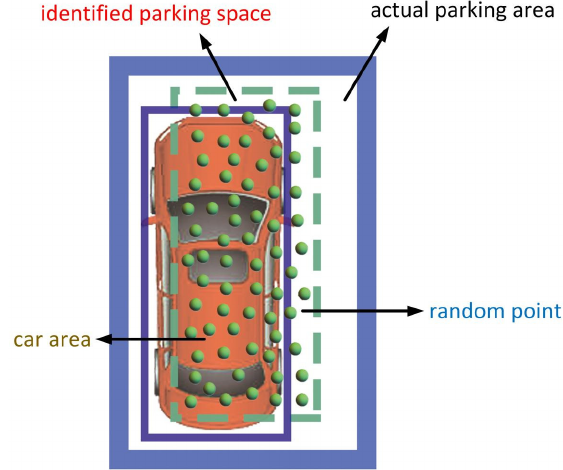
Figure 8. Distribution of one vehicle in a parking space.